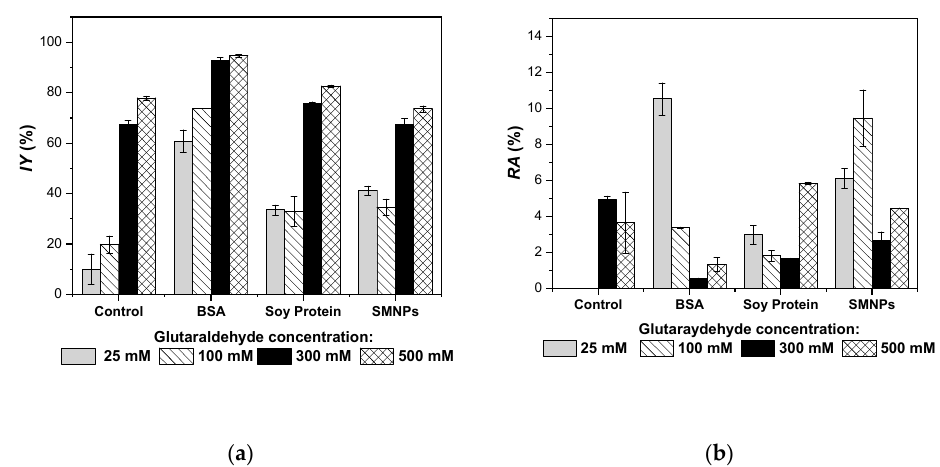
Figure 2. ( a ) Immobilization yields ( IY , Equation (3)) and ( b ) recovered activity ( RA, Equation (4)) of Eversa-crosslinked enzyme aggregates (CLEAs) prepared without and with protein co-feeders (bovine serum albumin (BSA), soy protein), or with silica magnetic nanoparticles (SMNPs). Experimental conditions: 5 mg/mL of enzyme solution, protein/co-feeder or additive mass ratio of 1:1, precipitation with ethanol (1:3 enzyme solution volume/ethanol volume), 4 °C, 150 rpm, 30 min of precipitation, followed by a 2.5 h treatment with glutaraldehyde. Hydrolytic activities were measured with tributyrin as the substrate (see Section 3.2).